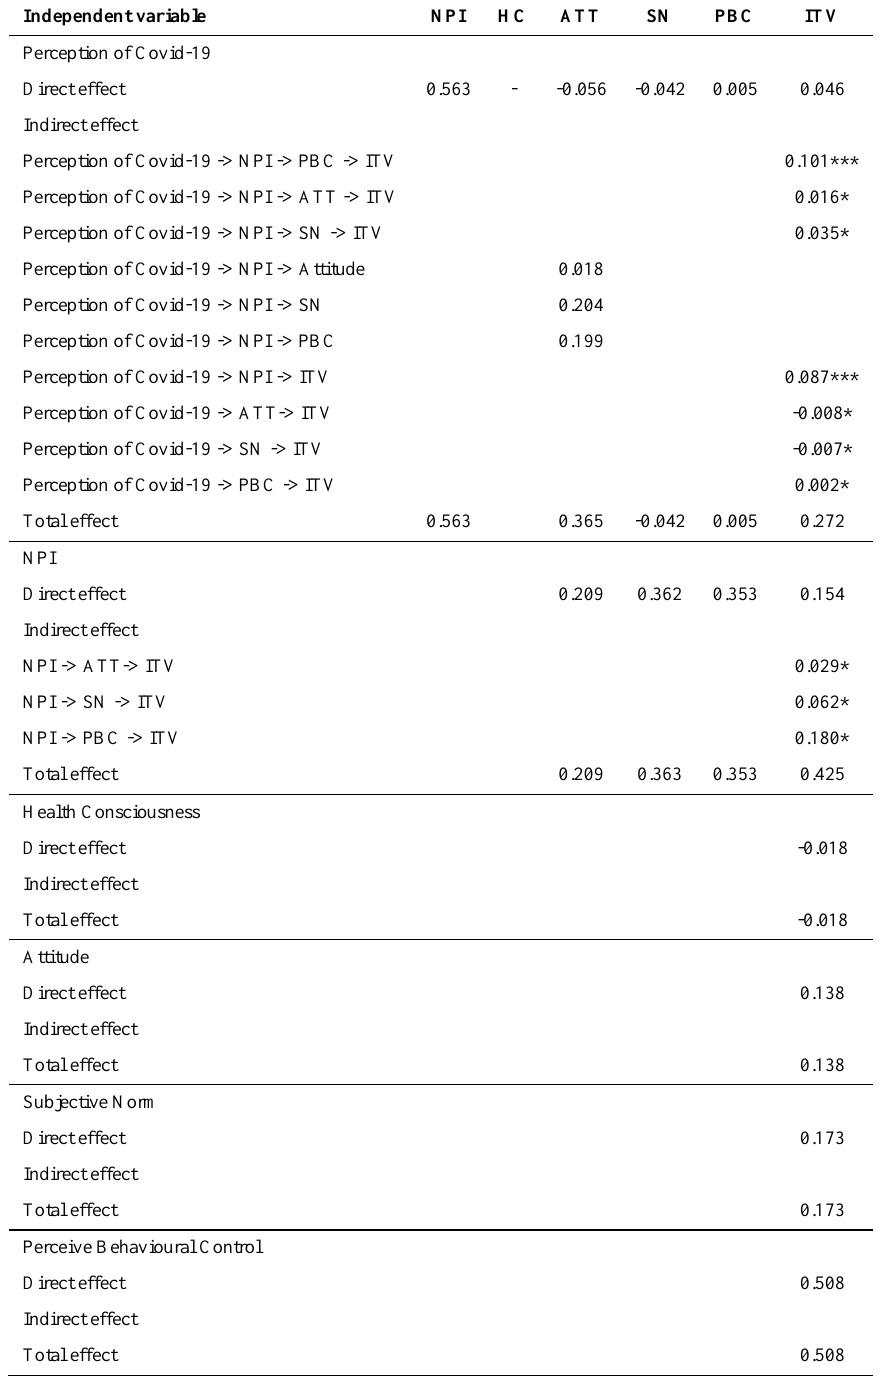
Table 7. The Direct, Indirect and Total Effect of the Structural